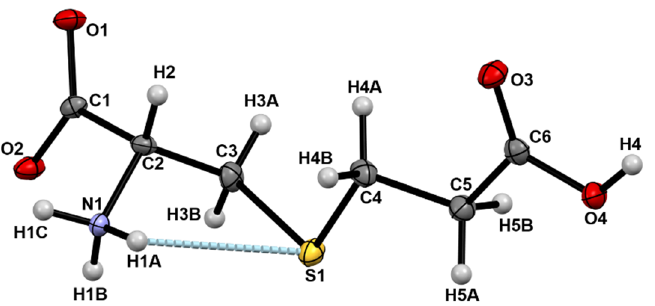
Figure 1. Atomic numbering and displacement ellipsoids at the 50% probability level for β -CEC. An intramolecular N-H···S interaction is shown as a dashed line.